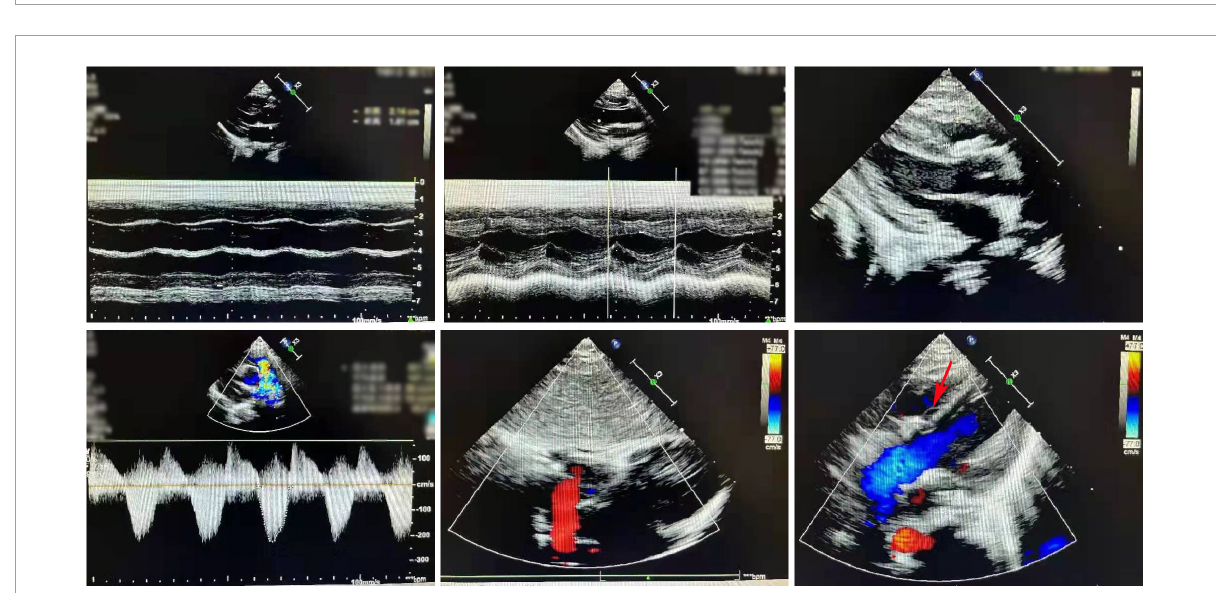
FIGURE2 A representative image of the cardiac ultrasound (postoperative) shows the normal internal diameter of each chamber, low septal motion amplitude, and strong plaque echoes around the septum. The right ventricular outflow tract is not obstructed. The muscle bundles are not hypertrophic. The internal diameter of the pulmonary artery was